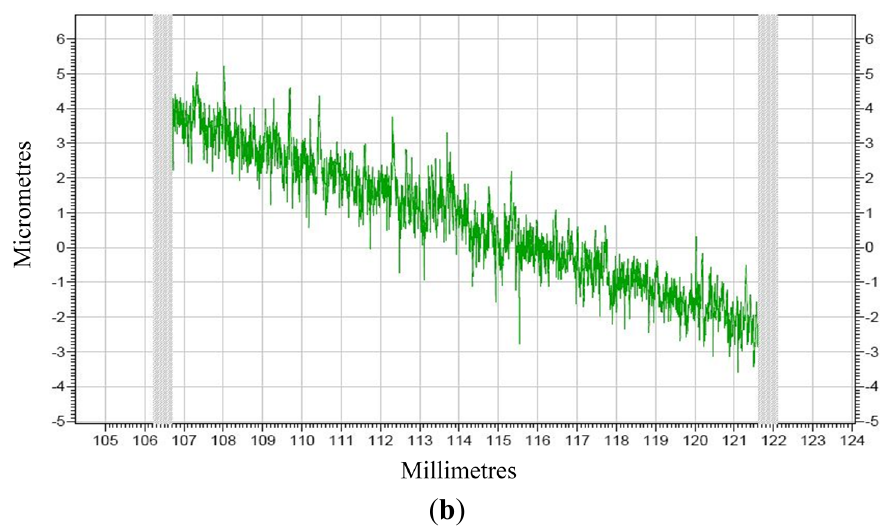
Figure 9. Raw profiles of machined surface ( a ) PEEK; ( b ) PEEK CF 30.